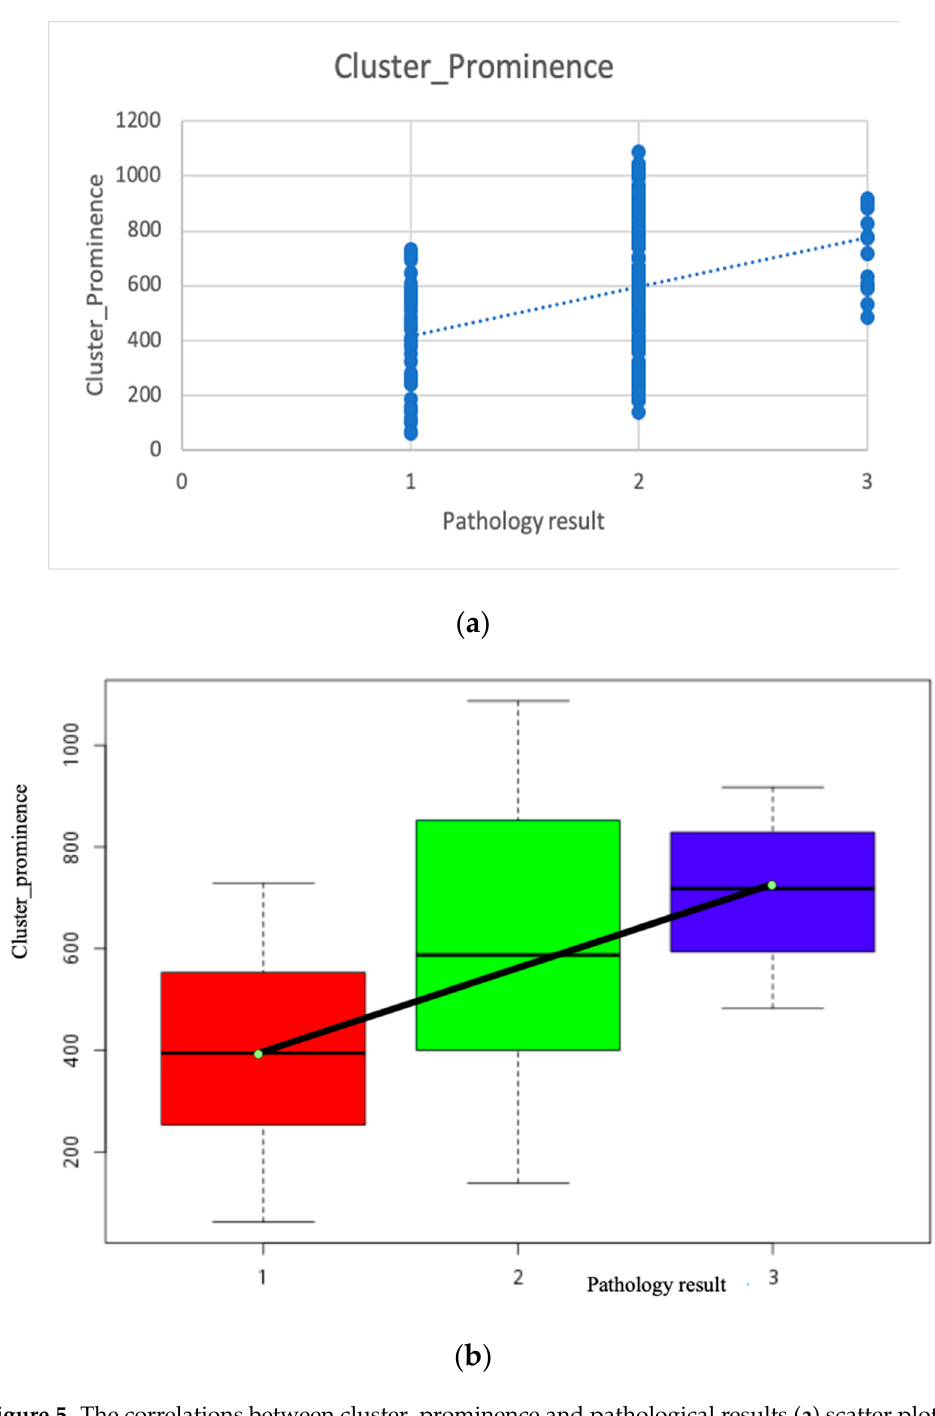
Figure 5. The correlations between cluster_prominence and pathological results ( a ) scatter plot and ( b ) box-and-whisker plot. Pathology result 1 is hyperplastic polyps. Pathology result 2 is adenoma. Pathology result 3 is colon adenocarcinoma.